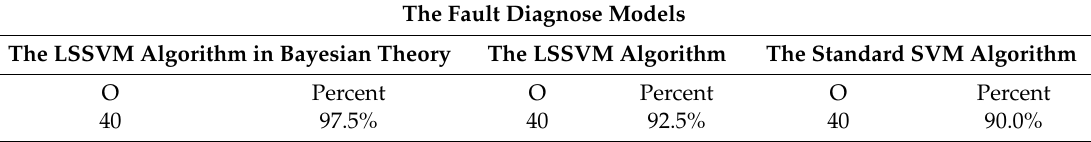
Table 5. The comparison of three models’ performance. LSSVM: Least Squares Support Vector Machine; SVM: Support Vector Machine.